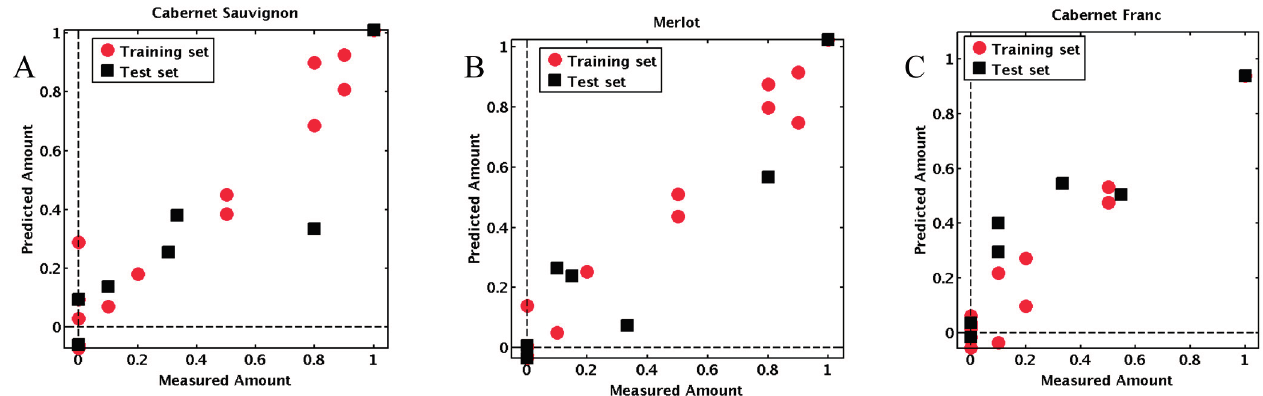
Figure 2. Performance of the Partial Least Squares Regression (PLSR) model using the di-blends as the training set ( ● ) in predicting the percentage of Cabernet Sauvignon ( A ), Merlot ( B ) and Cabernet Franc ( C ) in the tri-blend test set ( ■ ). The calculated RMSEP for the model was 0.18, 0.15 and 0.16 for C. Sauvignon, Merlot and C. Franc,